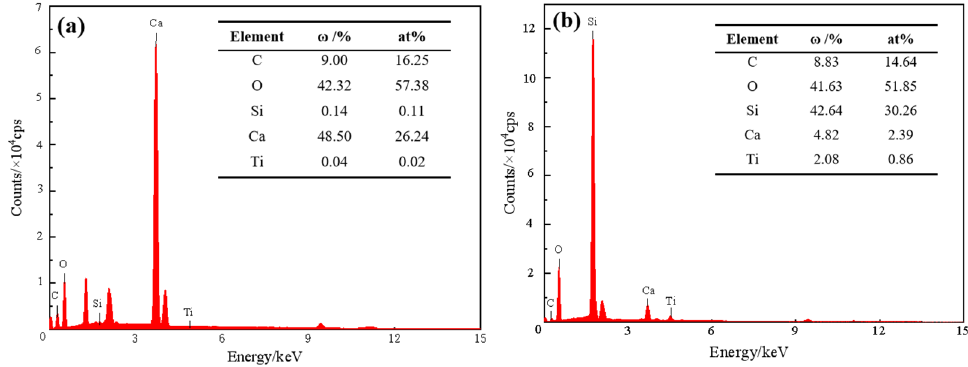
Figure 6. EDS energy spectrum of wall surface before and after coating. ( a ) Uncoated. ( b ) Coated with n (PDMS):n (TEOS) =